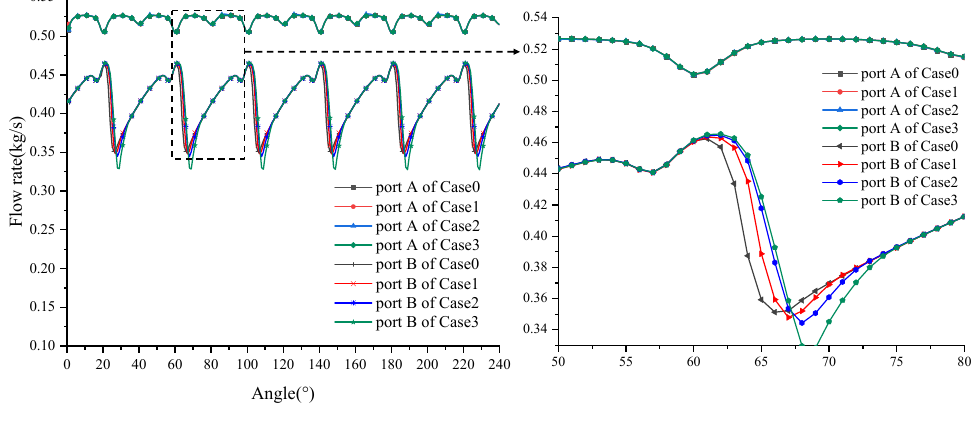
Figure 5. Numerical simulation flow rate of ports A and B.